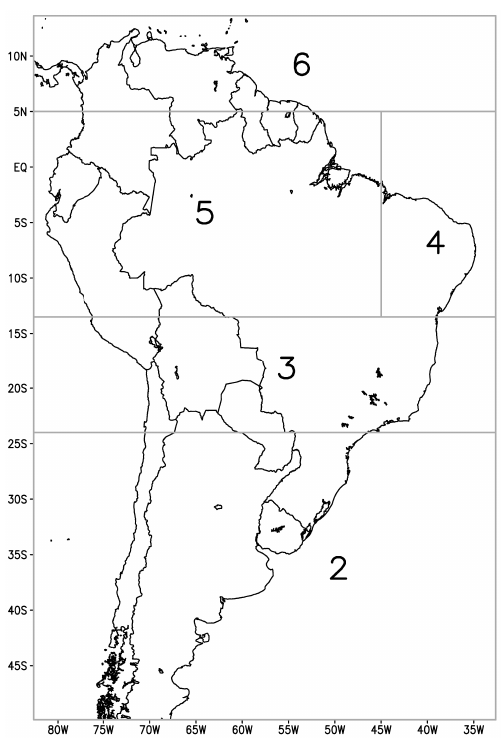
Fig. 2. Areas used to calculate the statistical scores. The numbers represent corresponding areas indicated in the